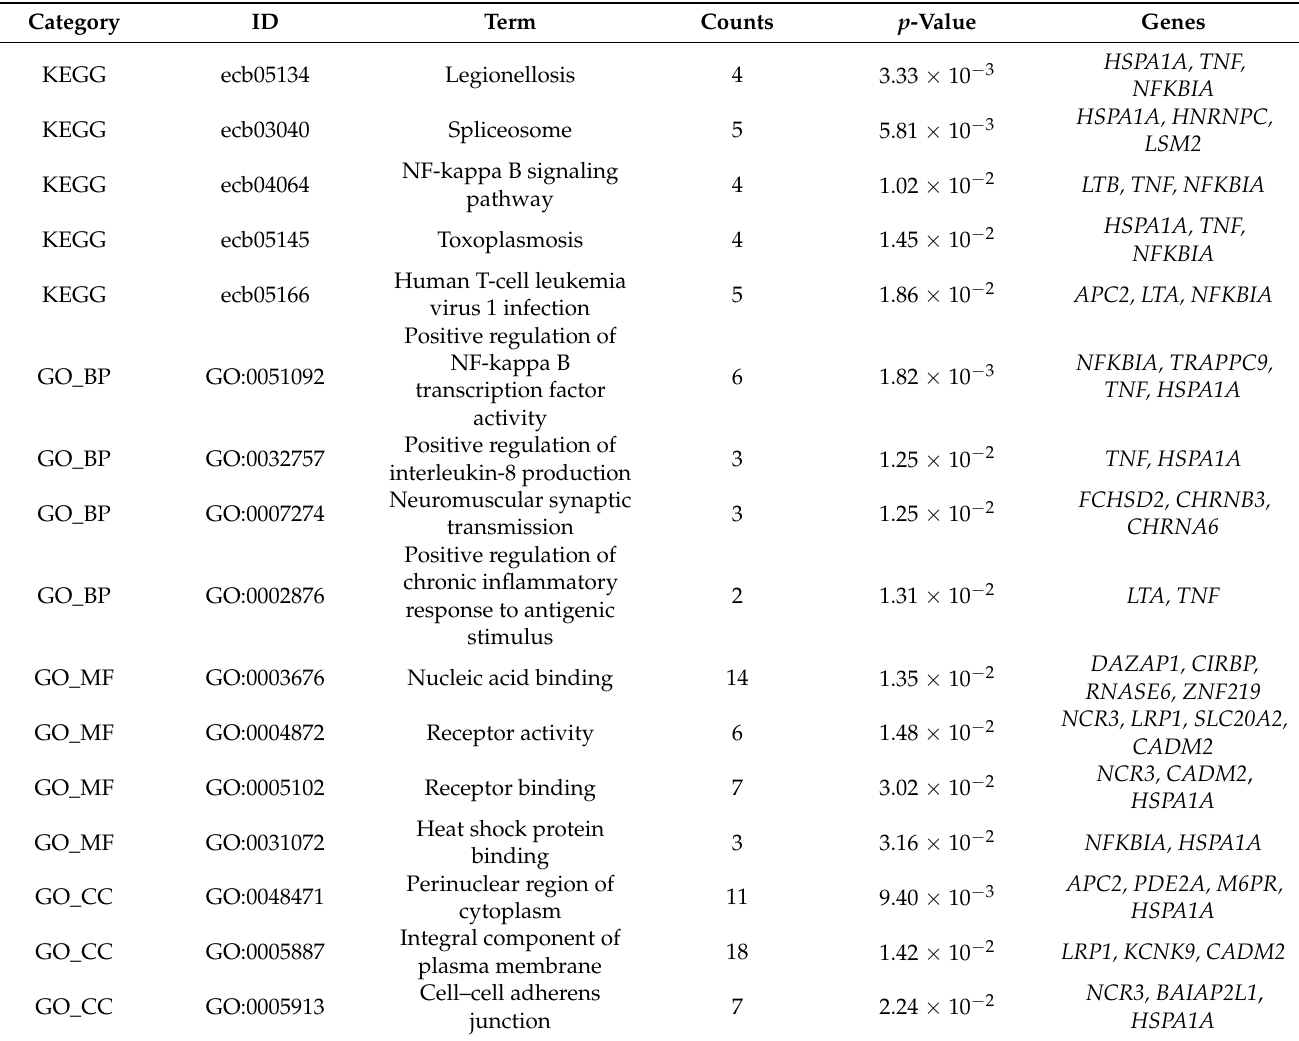
Table 6. Functional enrichment analysis of CNVR-overlapping genes in the Jinjiang